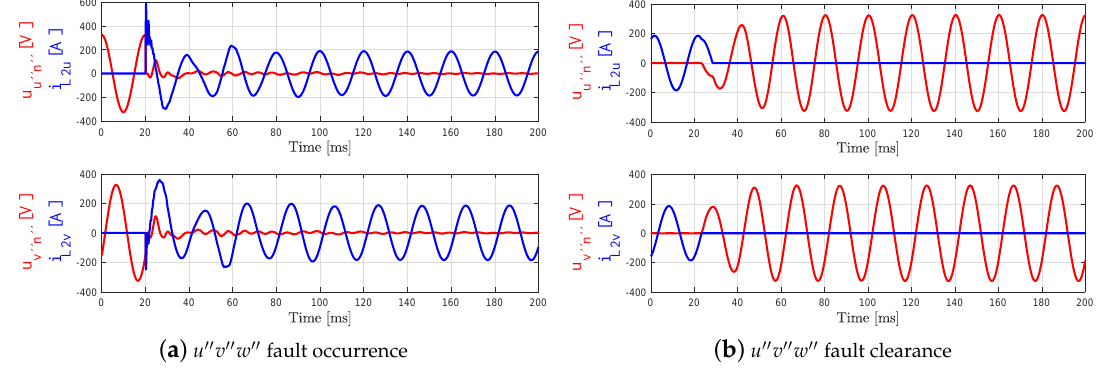
Figure 14. Scenario 3 (three-phase